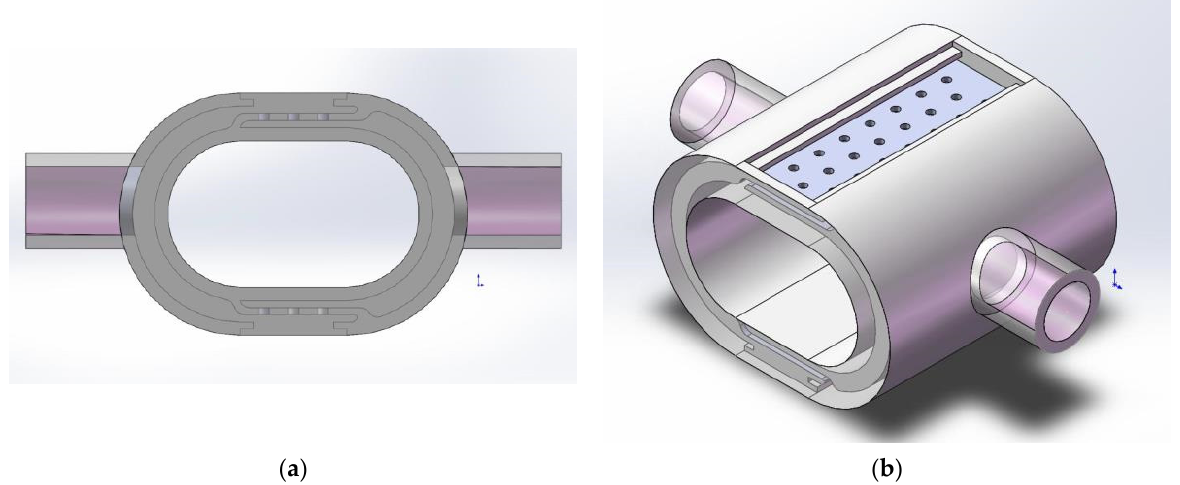
Figure 18. Cold side impingement jet geometry of a automotive TEG system ( a ) Front View; ( b ) Isometric View. Reprint with permission [87]; Copyright 2021, Dr. Pandit.